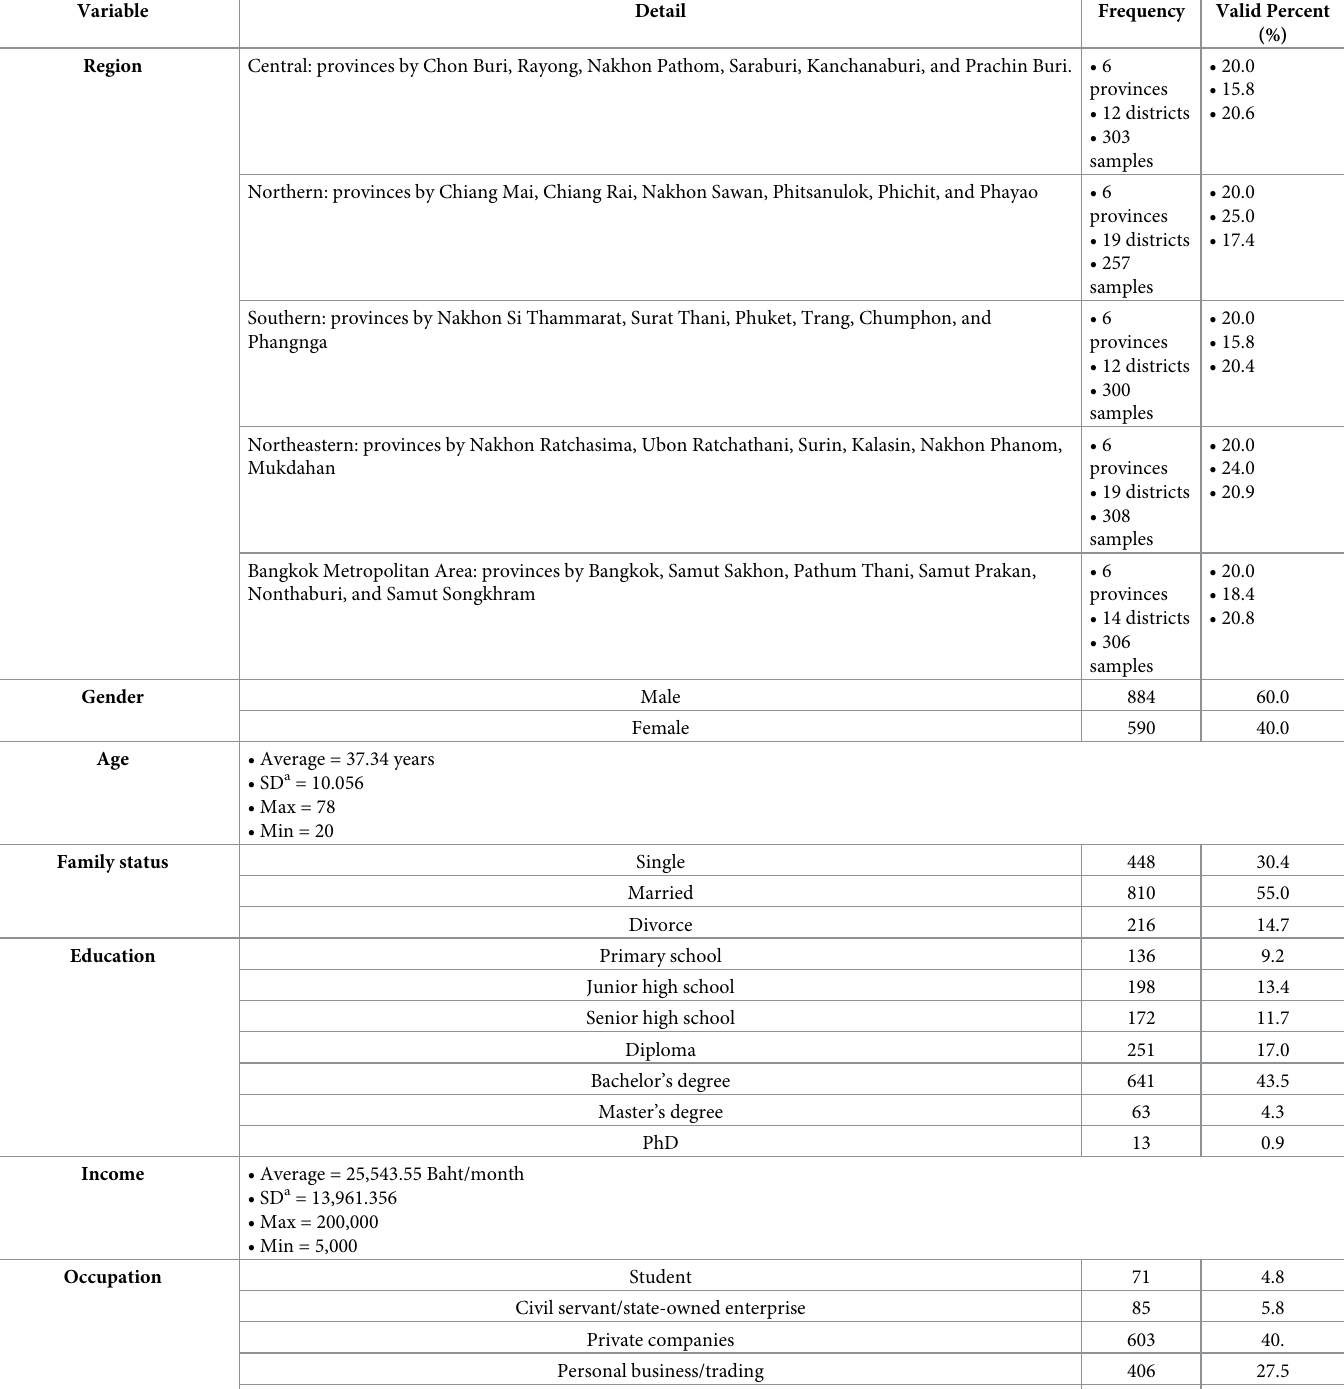
Table 1. Characteristics of the participants; n =